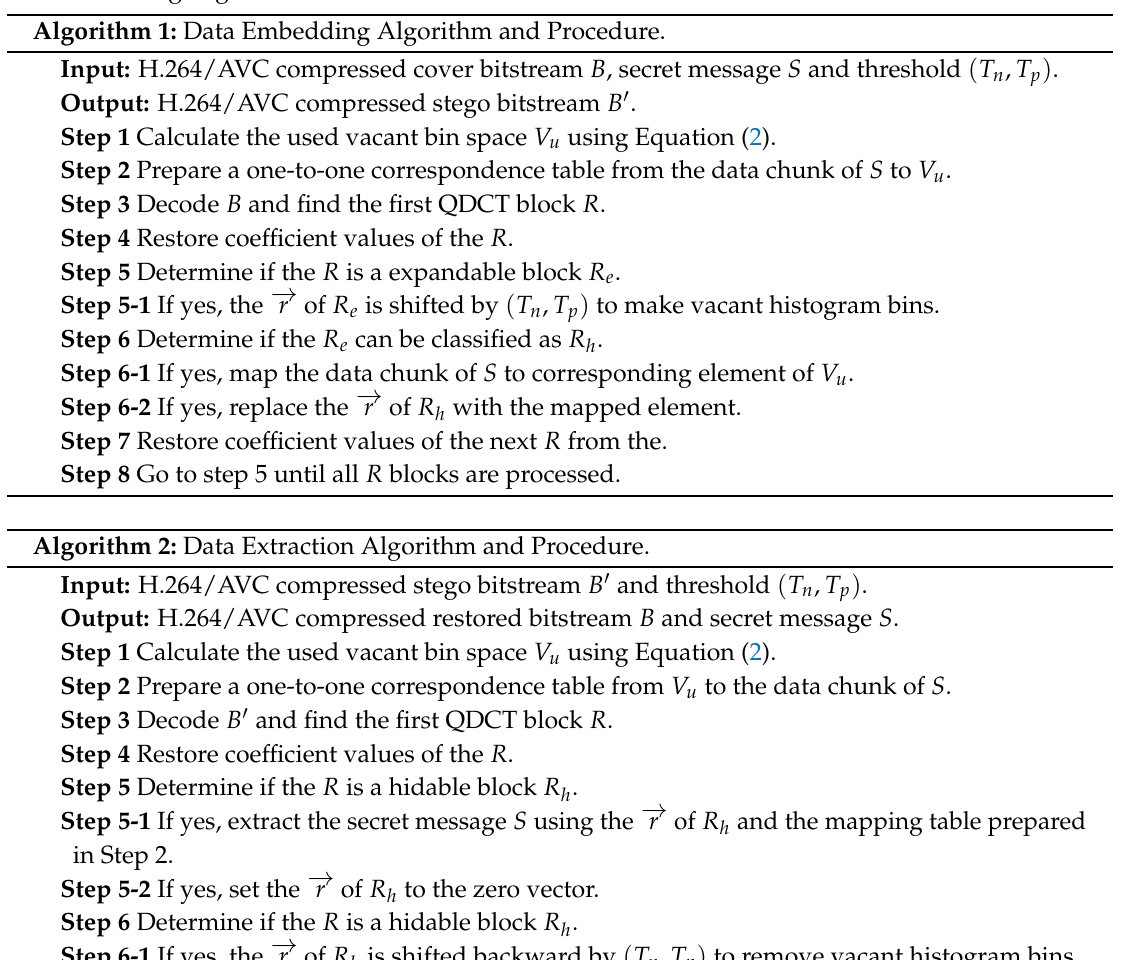
Algorithm 1: Data Embedding Algorithm and Procedure.